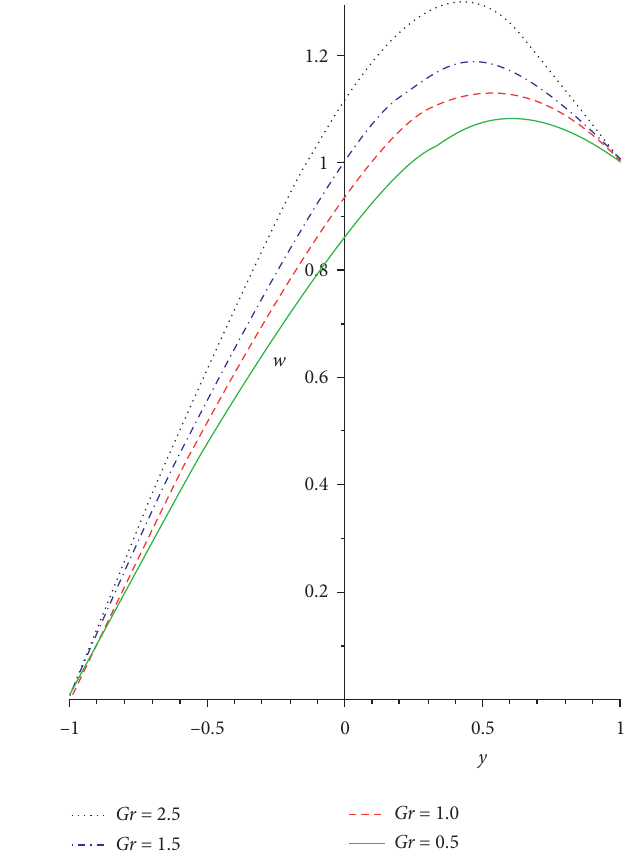
Figure 3: Velocity profile for increasing Gr .